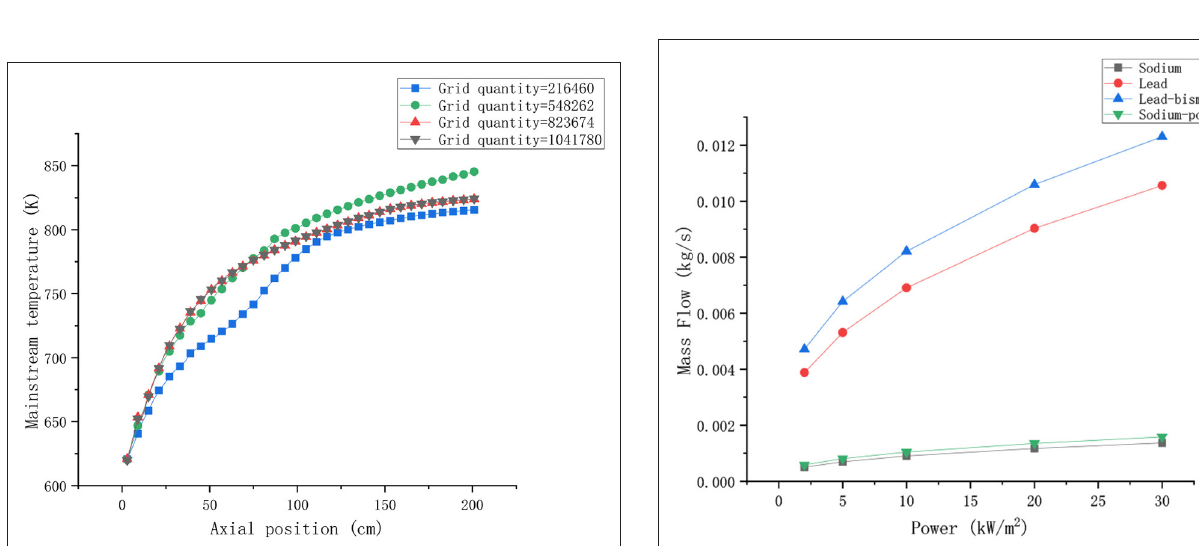
FIGURE 4 | Effect of heating power on heat transfer coefficients of different liquid metals.